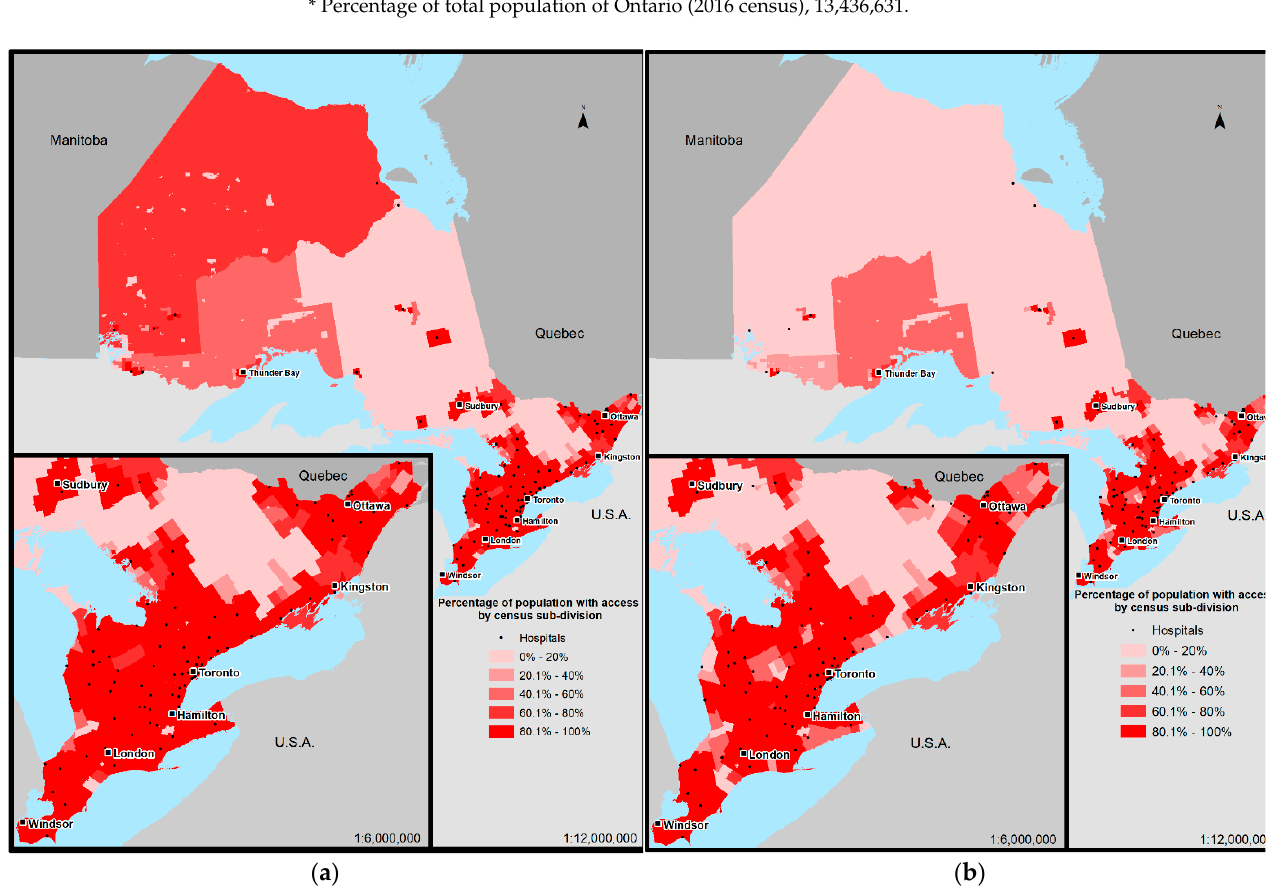
Figure 1. Percentage of Ontario population with access to any emergency general surgery care by census sub-division ( a ), versus those with access to all factors, including 24/7 operating room ( b ), within 30-min driving time. • denotes the location of a hospital, names denote major regional city centers.